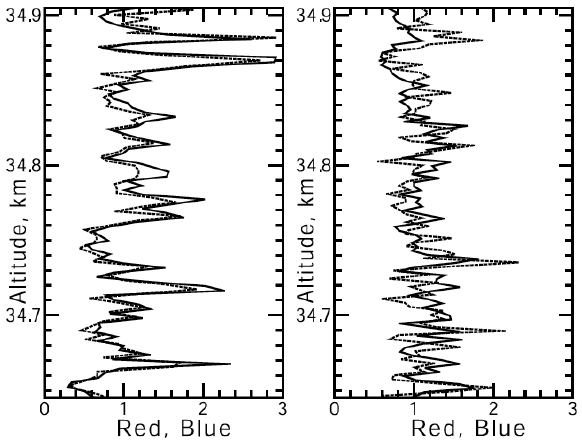
Fig. 51. Comparison of two records of two-wavelength scintillations ((left) vertical, (right) oblique at 46°). Abscissa is red (672 nm, dashed line) and blue (499 nm, solid line) intensities normalized on the corresponding mean. Ordinates are altitude of ray perigee. The correlation is poorer for oblique occultation, because of the effect of isotropic turbulence (from Gurvich et al., 2005).